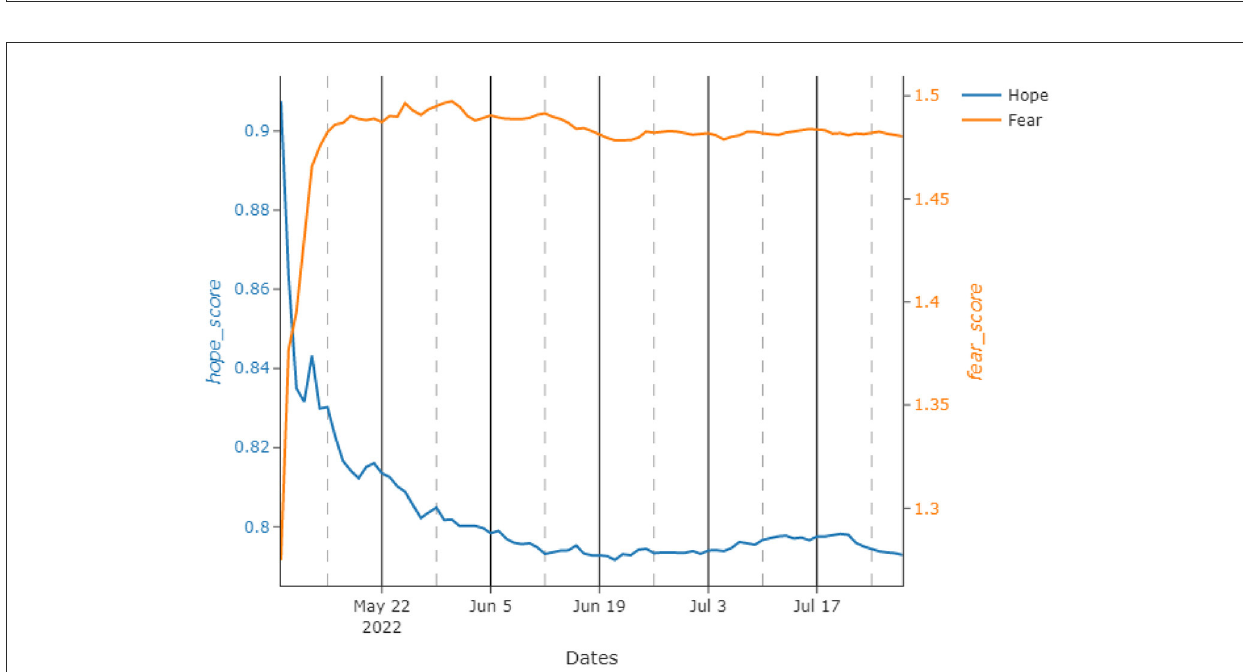
FIGURE3 Running means for the proposed hope and fear scores during the test interval between May and July 2022. The left y -axis refers to hope score , whilst the right one is for fear score